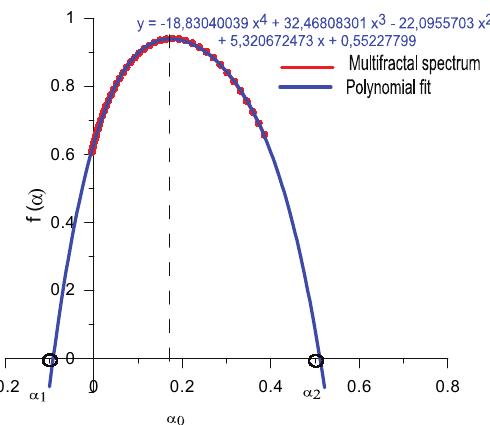
Fig. 6. Sample of a multifractal spectrum with critical exponents Da and its most expected value of a 0 when mixture composition was modified in cylinder 1